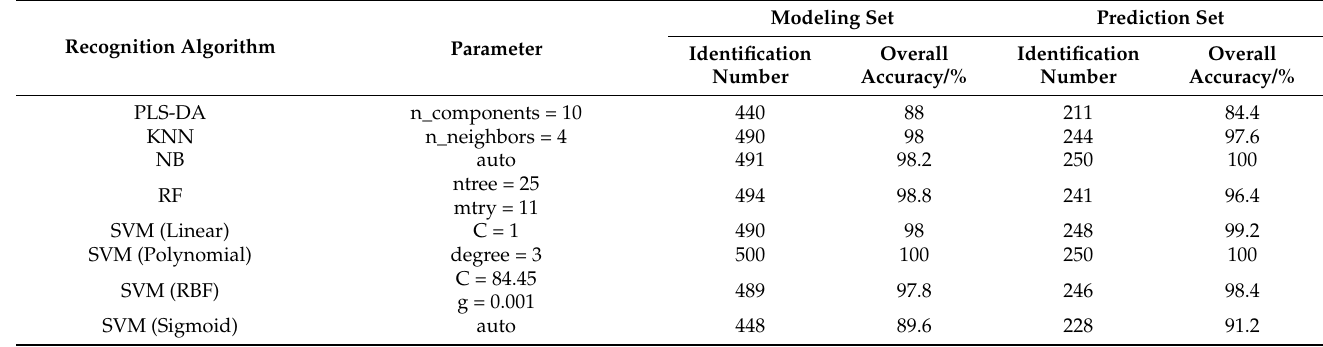
Table 3. The total recognition results of diffident models based on full-spectrum.